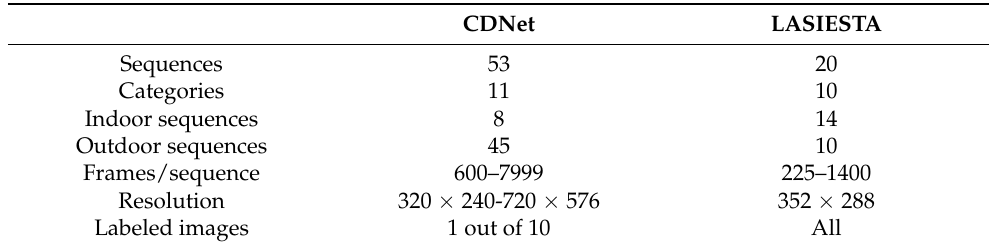
Table 2. Main features of CDNet and LASIESTA